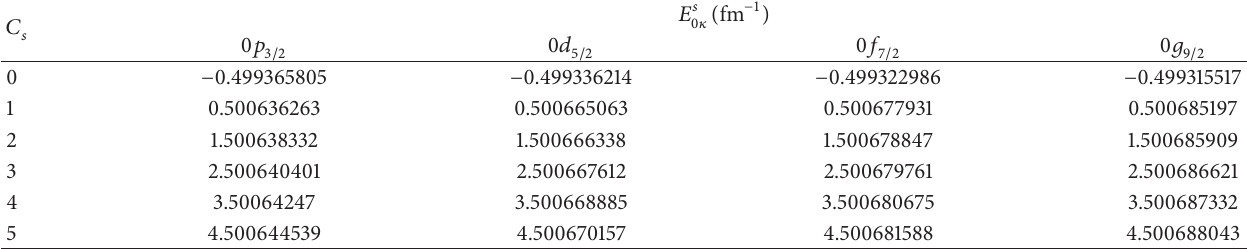
Table 4: Energies in the spin symmetry limit for 𝐴 𝑠 = −0.5 , 𝑎 𝑠 = 0.02 , 𝑏 𝑠 = 0.01 , and 𝑀 = 0.5 fm −1 .